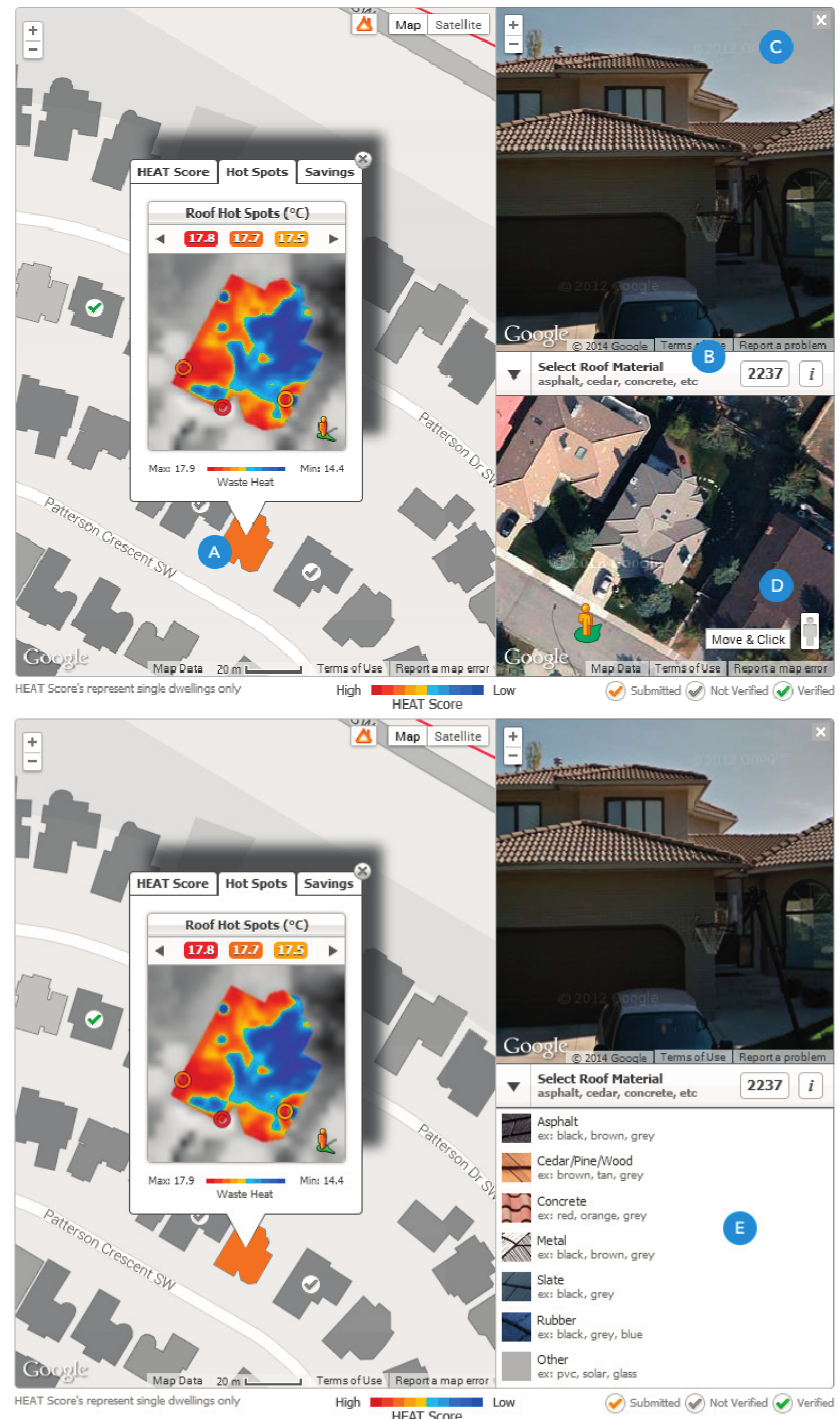
Figure 2. The final UI of the HEAT VGI application available on http://saveheat.co. Once the house polygon is clicked ( A ), a panel including both the ( B ) dropdown menu (with total classified roofs, and link to a help file) and ( C ) Google Street View and ( D ) Satellite imagery appears that can be used to assess the roof material. Once the dropdown menu is clicked (see following image), a scrollable list of roof material classes ( E ) is displayed to the